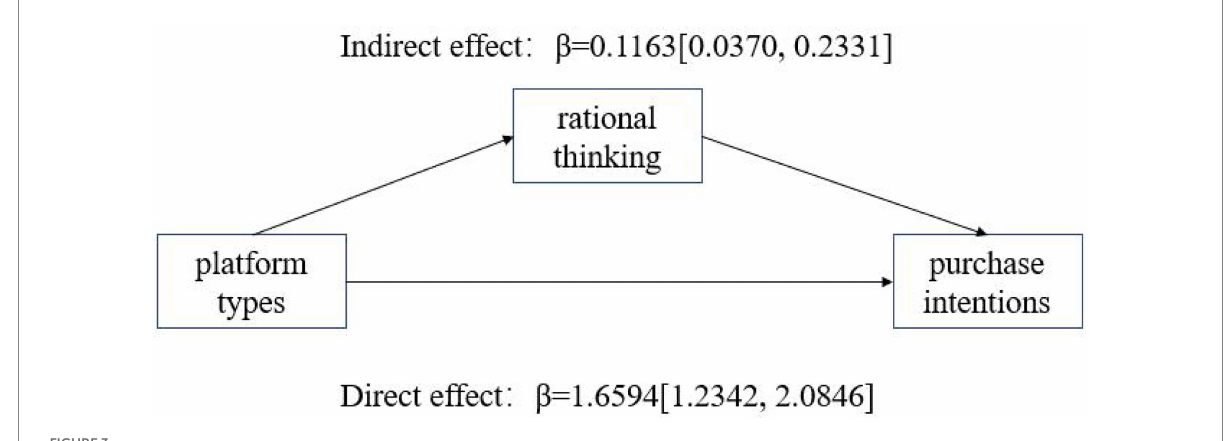
FIGURE 3 Mediated test of rational thinking (goal-driven consumers).